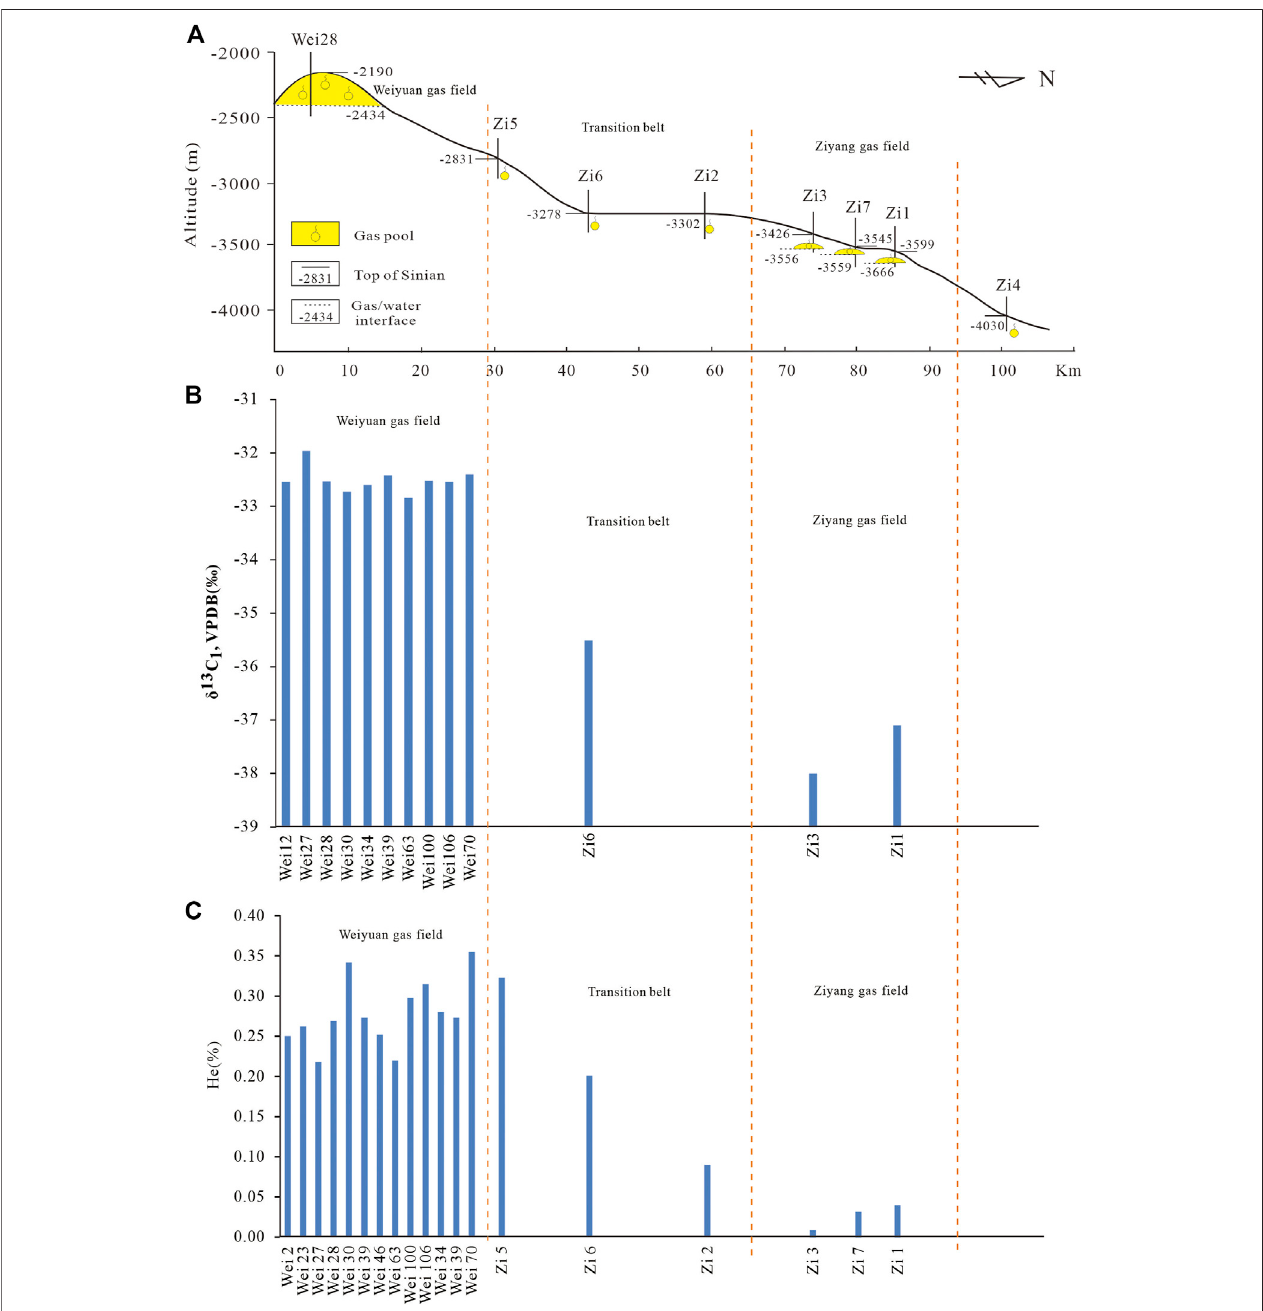
FIGURE9| Helium contentofnatural gasesintheSinianDengyingFormation intheWeiyuangas fi eldand itsadjacentareas.(The locationofpro fi leABisshown in Figure 7 .The helium data cited from Dai et al.,1999; Dai, 2003; Zhuet al.,2007). (A) Section ofWeiyuangas fi eld and adjacentarea. (B) The δ 13 C 1 ofWeiyuan gas fi eld and adjacent area. (C) The helium content of Weiyuan gas fi eld and adjacent area.